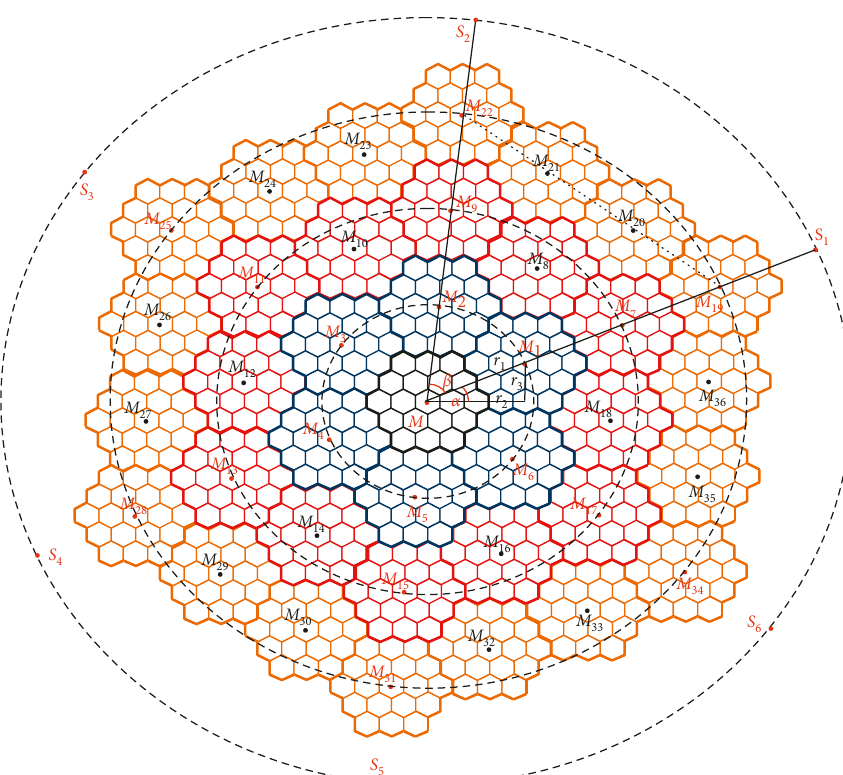
Figure 3: Architecture of the EHCA protocol.